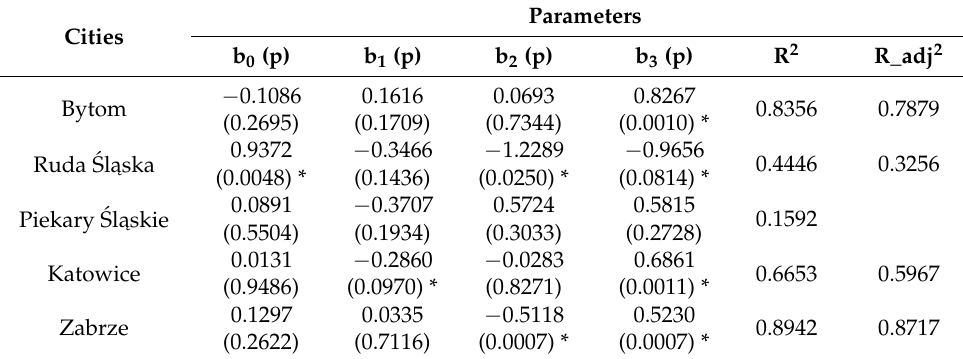
Table 6. Parameters of the multivariate regression function for the examined cities. Cities